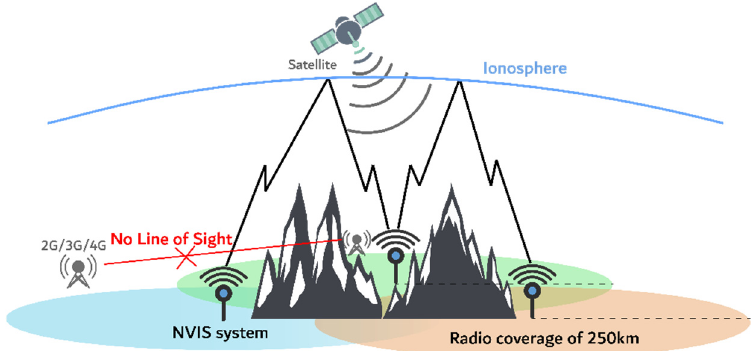
Figure 1. Near vertical incidence skywave (NVIS) link scenario.